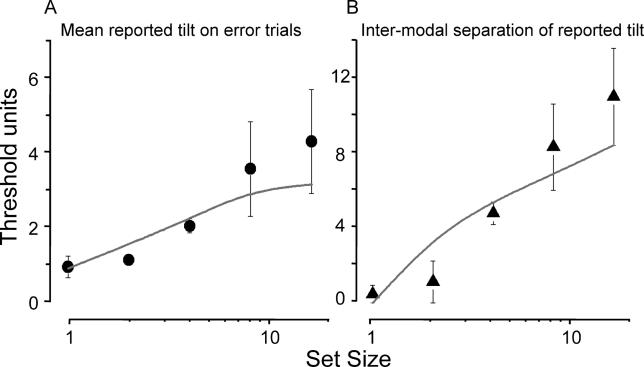
Two Estimates of How Perceived Tilt Varies with Set Size(A) Mean perceived tilt of all erroneous trials in near-threshold conditions, averaged across observers (n = 5 at set sizes 1 and 16;n = 4 otherwise). The error bars show the standard error of the mean between observers.(B) Distance between the modes of the response distributions (like those ofFigure 3) as a function of set size, averaged across the same observers as shown in (A). The curves of each observer at each set size were first tested for bimodality (see legend toFigure 3). If judged unimodal, the separation was considered zero; otherwise, the distance between the positive and negative peaks was measured and normalized by the individual threshold angle at set size 1. In both plots, the smooth curves show the predictions of simulation of the signed max model, assuming first-stage Gaussian noise of unit standard deviation. The data follow the predictions reasonably well.